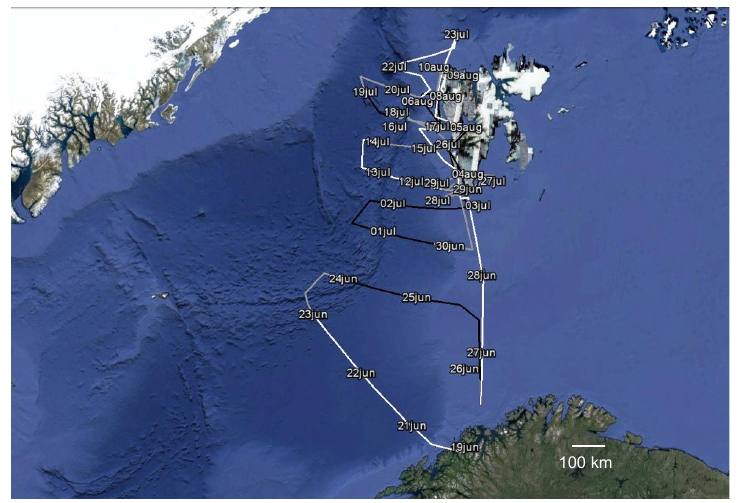
Figure 2. Route of the Oceania during the AREX cruises from Tromsø to Svalbard.